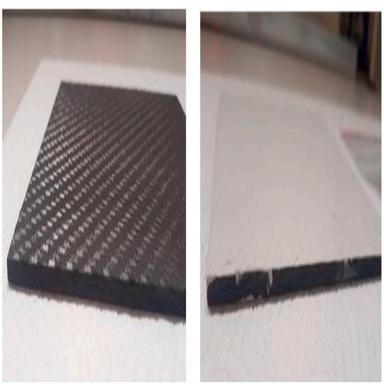
C/C substrate and coating: square tile cut out from commercial C/C slab (left), coated specimen for the thermal characterization (right).